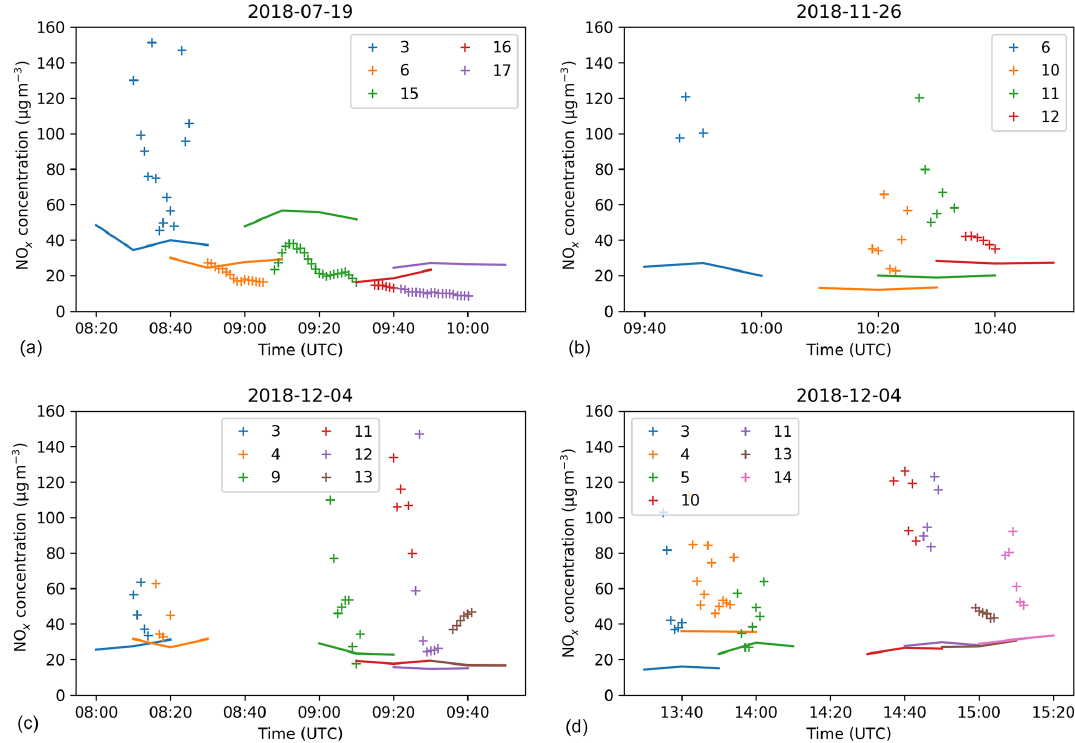
Figure 30. Mobile NO x measurements ( + markers) and modelled concentrations (solid lines) for the morning of 19 July (a) , the morning of 26 November (b) , the morning of 4 December (c) , and the afternoon of 4 December (d) . Numbers refer to mobile measurement locations according to Fig.